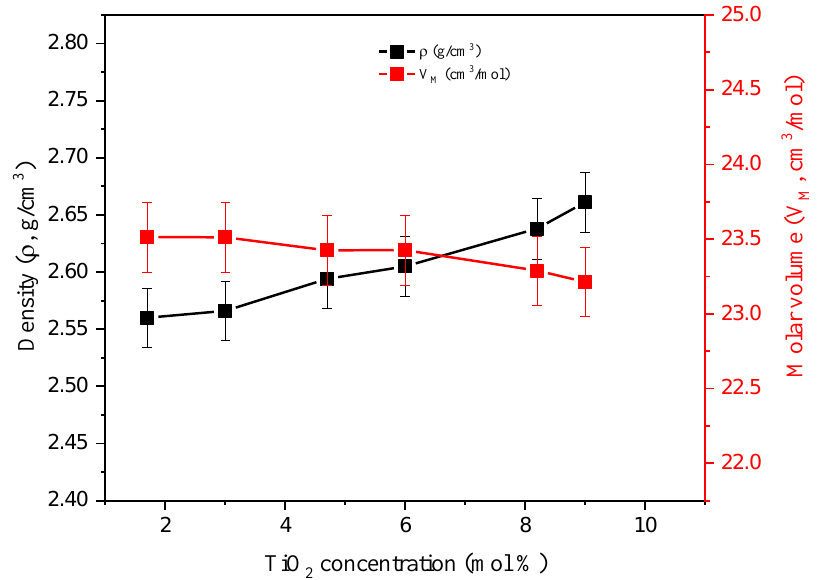
Figure 1. Variation of glass density and molar volume versus TiO 2 concentration.